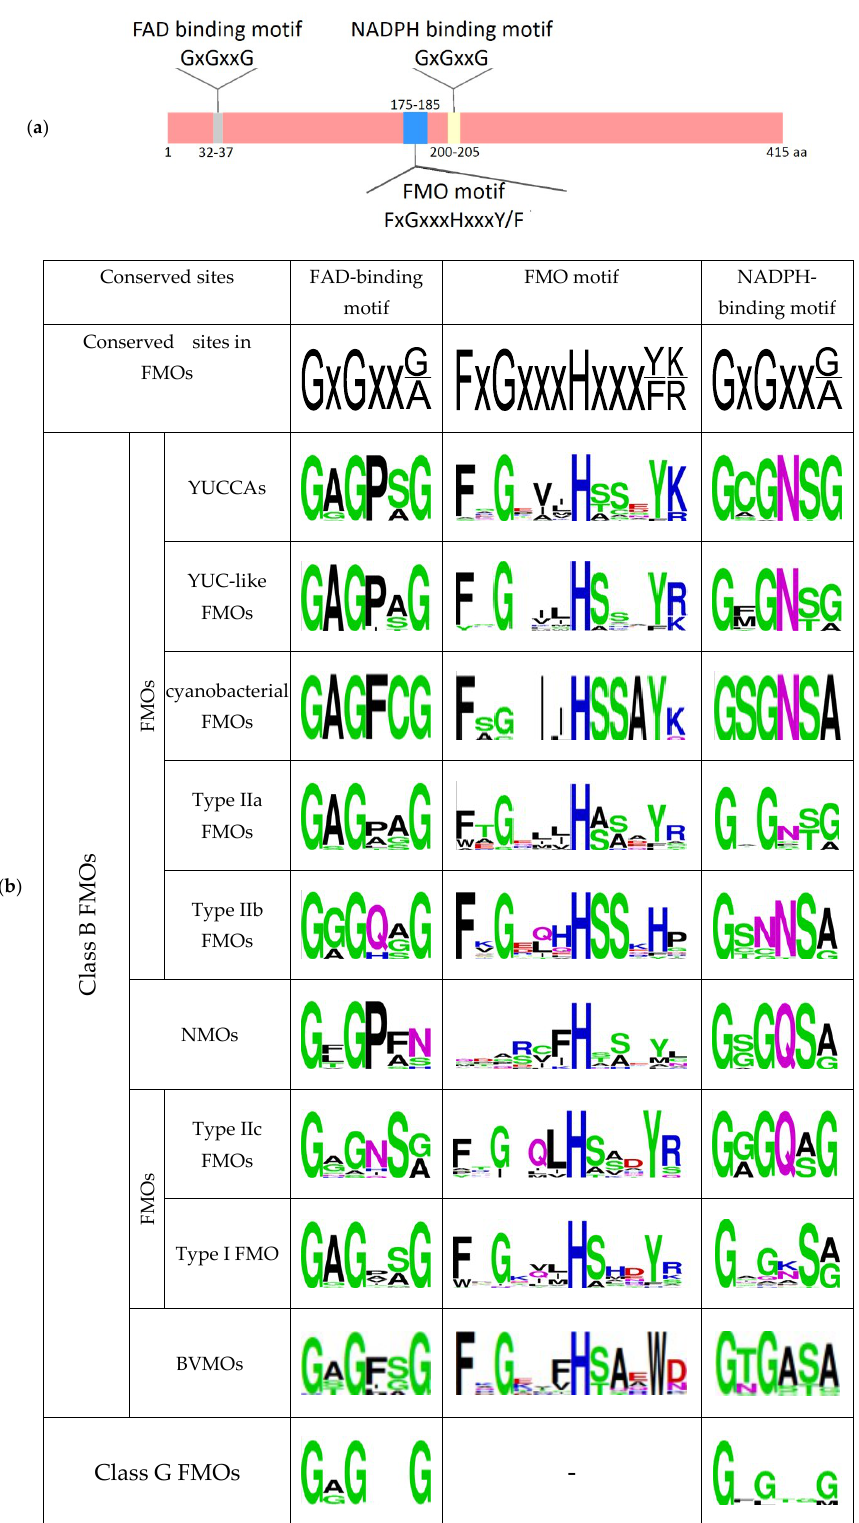
Figure 2. WebLogo representation of the key functional sites in the FMO/ Baeyer–Villiger monooxygenase (BVMO) protein homologs. ( a ) Scheme of arrangement of the conserved motifs in FMO proteins (the amino acid positions are shown according to the A. thaliana YUC2 sequence, AT4G13260). ( b ) The consensus of the three motifs—FMO-binding, FMO, and nicotinamide adenine dinucleotide (NADH)-binding (Columns 2–4,